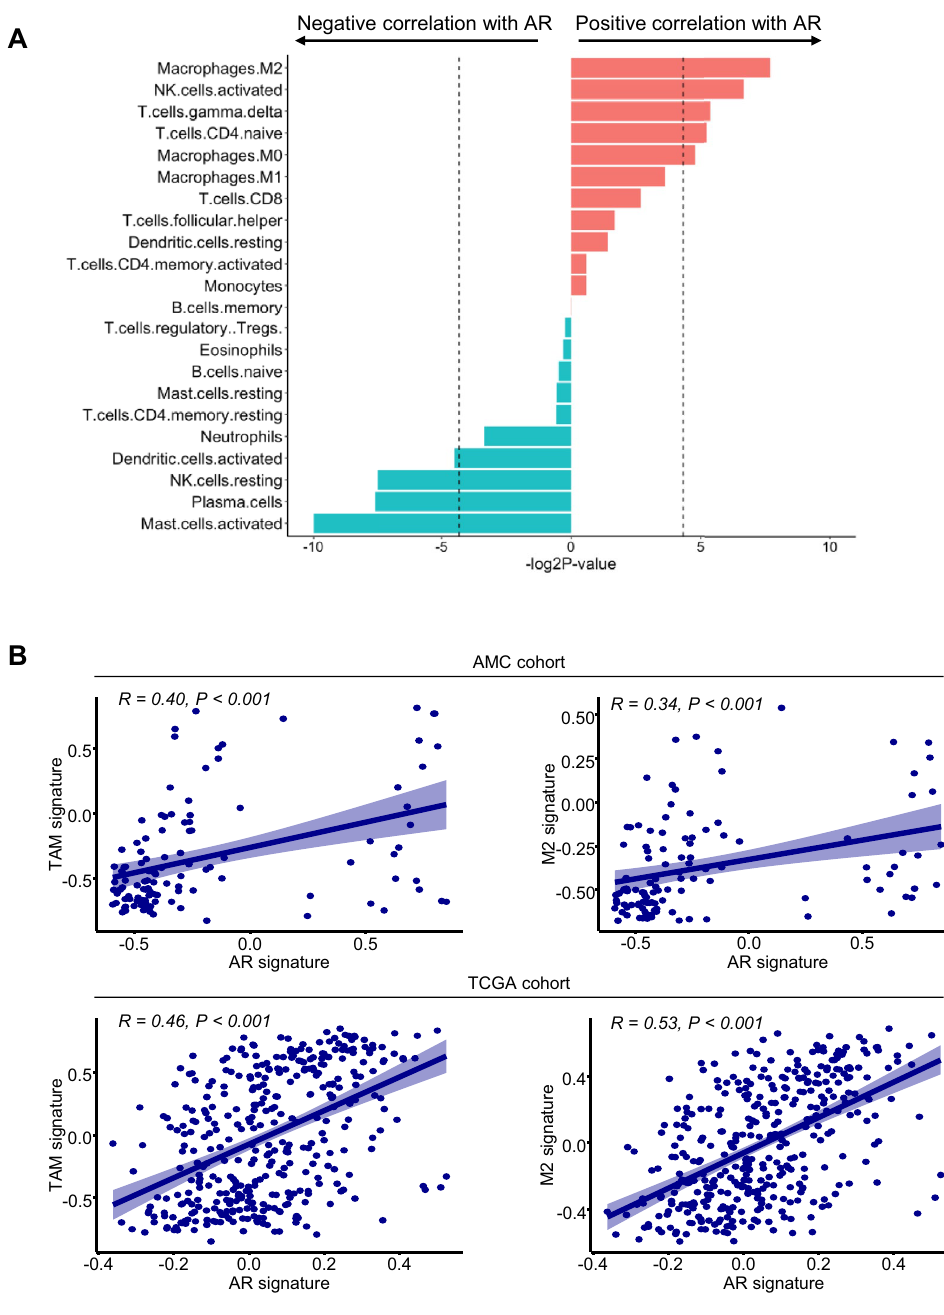
Figure 2. Correlation between the expression levels of the AR signature and M2 macrophage-related parameters. ( A ) Bar graph showing the correlation between the expression levels of the AR signature represented by the enrichment score calculated by Gene Set Variation Analysis (GSVA) and the abundance of immune subsets estimated by CIBERSORT. ( B ) Correlation between the expression levels of the AR gene signature and tumor-associated macrophages and M2 macrophage signatures in the study cohort (upper panel) and TCGA cohort (lower